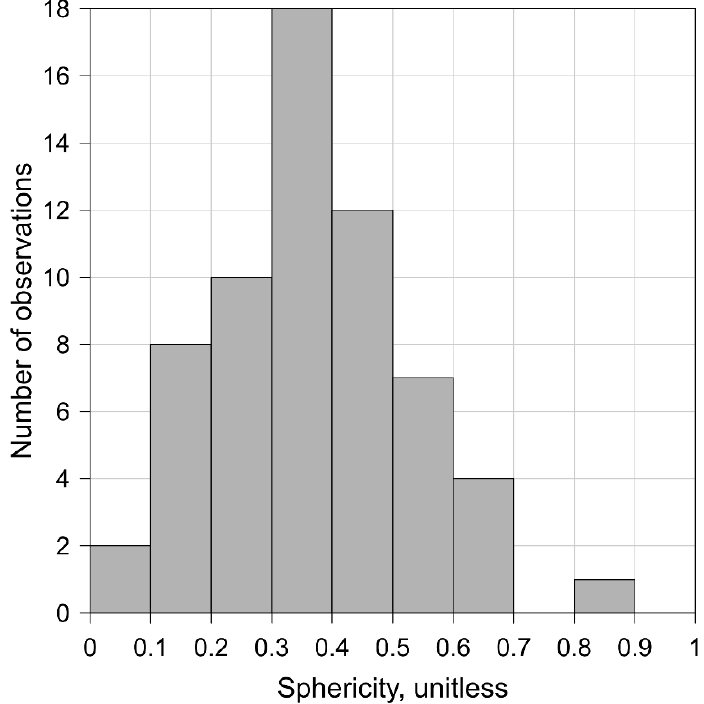
Figure 9. Histogram of object sphericity, based on the largest objects in the samples.